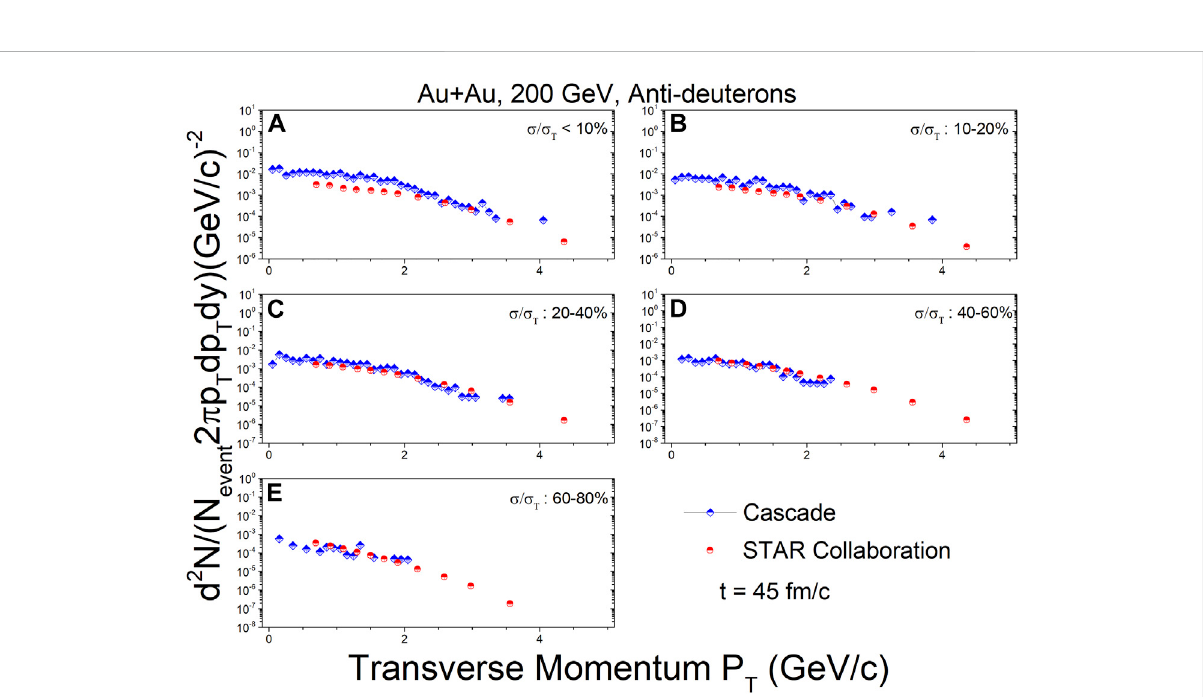
(cid:1)(cid:1)(cid:1)(cid:1) √ s NN Inthe =200 GeVAu+Aucollisions,0, − ,10%,10, − ,20%,20, − ,40%,40, − ,60%and60, − ,80%centralityin t =45 fm / c intheanti-deuteron transverse momentum spectrum. Calculations are represented by signs + lines. Experimental data from the STAR collaboration [27] are represented as circles. The parameter sets of ( R 0 , P 0 ) is (3.575 fm, 0.285 GeV/ c